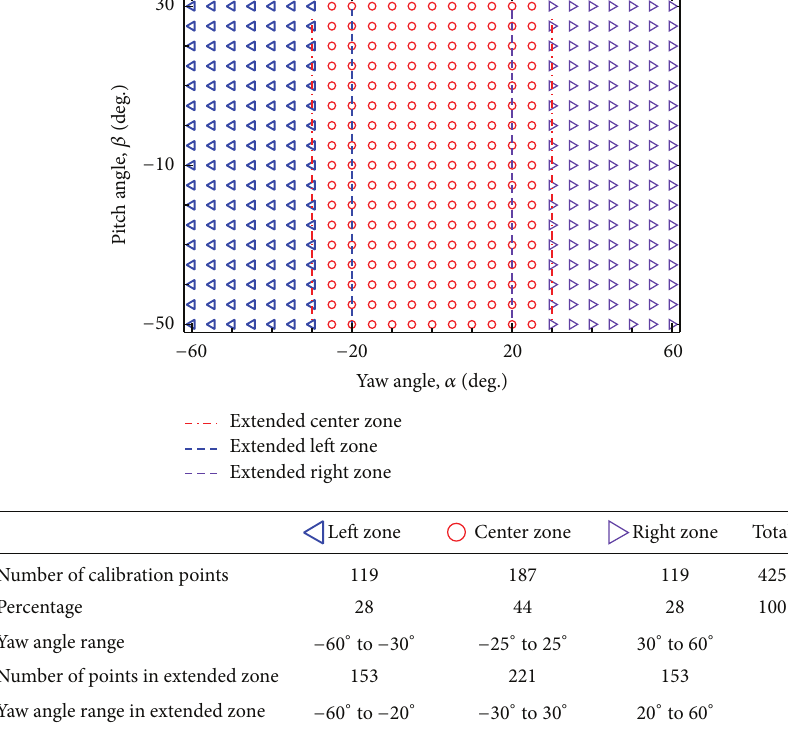
Figure 5: Zone division including extended